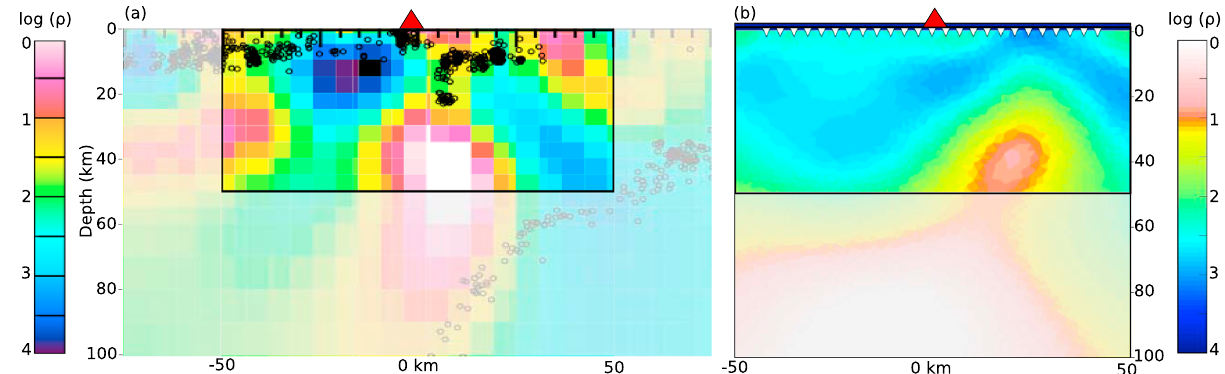
Fig. 4 Original (a) and synthetic (b) MT models for southern Kyushu. Colour scale is log electrical resistivity ( ρ ). a Shows the inverse MT model in southern Kyushu crossing the Kirishima arc volcano from adapted Hata et al 21 with the region of interest highlighted. Reprinted by permission from John Wiley and Sons, Journal of Geophysical Research: Solid Earth, 3-D electrical resistivity structure based on geomagnetic transfer functions exploring the features of arc magmatism beneath Kyushu, Southwest Japan Arc, Hata et al 21 , ©2017. b is the synthetic model, produced from a subsurface with conductivities de fi ned by mantle peridotite, arc melts, and the phlogopite-pyroxenite metasome, melt, and saline fl uids produced by melting of subducted sediments. The synthetic model approximately reproduces the conductor extending to ~50 km depth just trenchward of Kirishima volcano (red triangle). Shading at depths >50 km re fl ects poorer model resolution at these